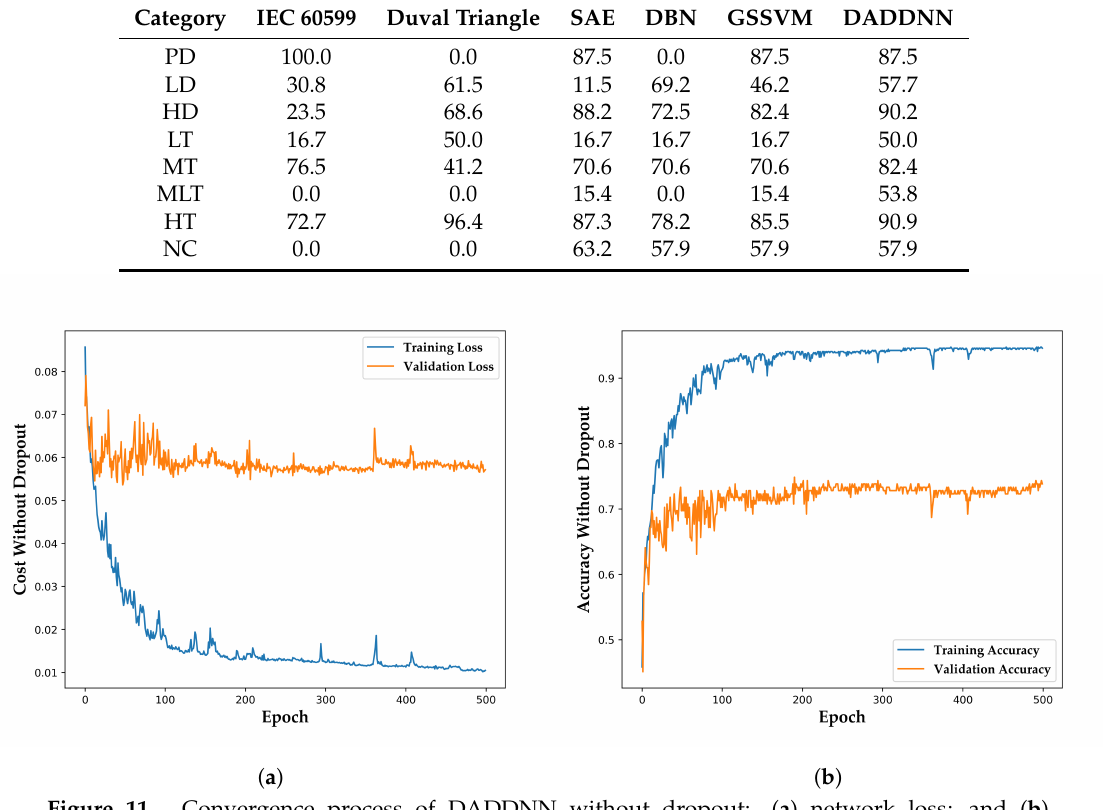
Figure 11. Convergence process of DADDNN without dropout: ( a ) network loss; and ( b ) diagnosis